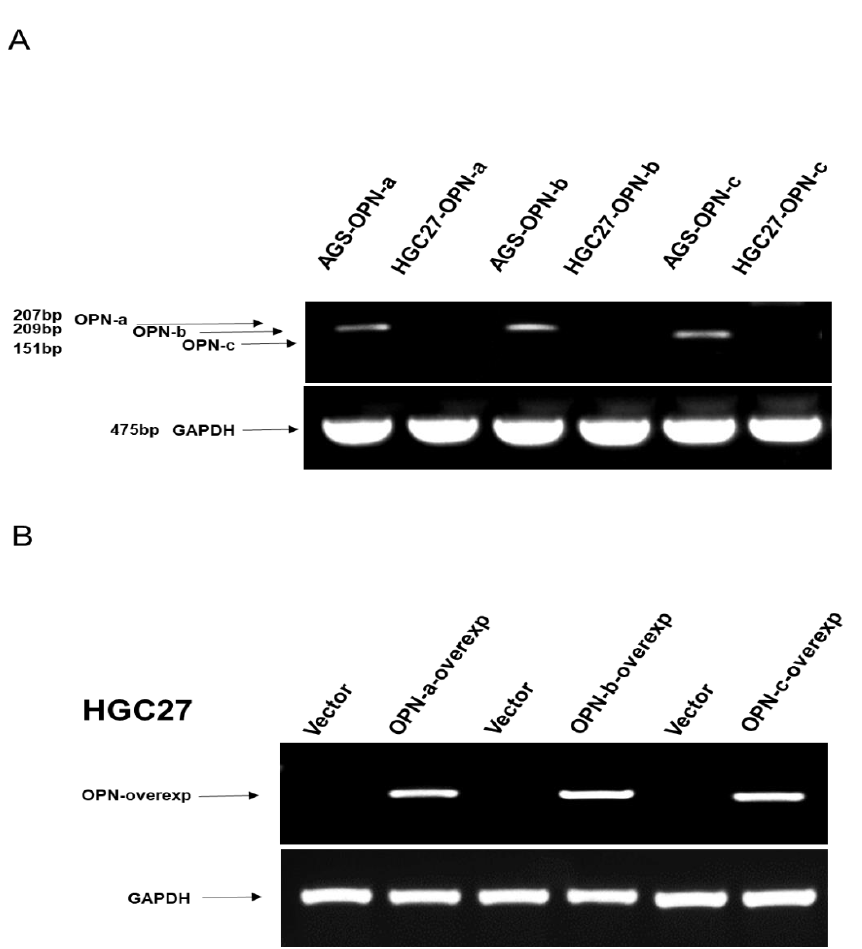
Figure 2. The expression of OPN genes in tissue from gastric cancer patients. ( A ) The expression of OPN-a, OPN-b, and OPN-c (207bp, 209bp and 151bp respectively) were detected via RT-PCR.